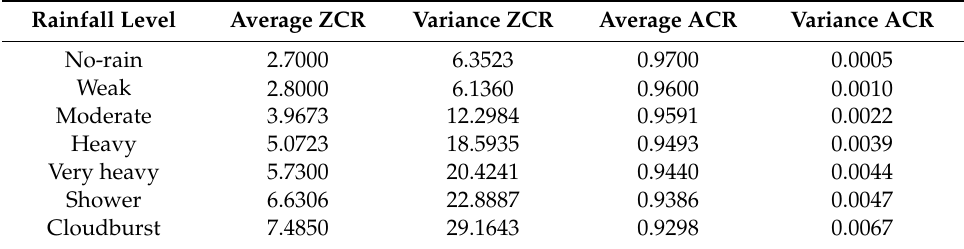
Table 7. Comparison of ZCR and ACR values between different rainfall classification levels.